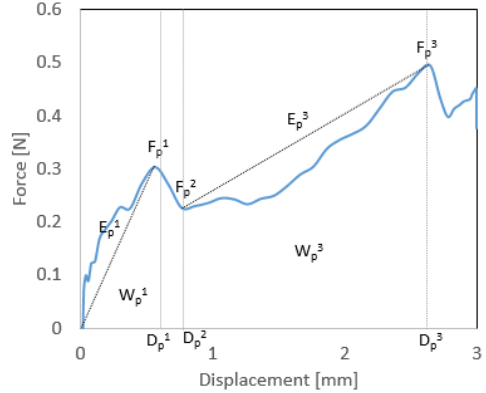
Figure 2. Force/displacement curve obtained from puncture test on fruit skin and extracted parameters.